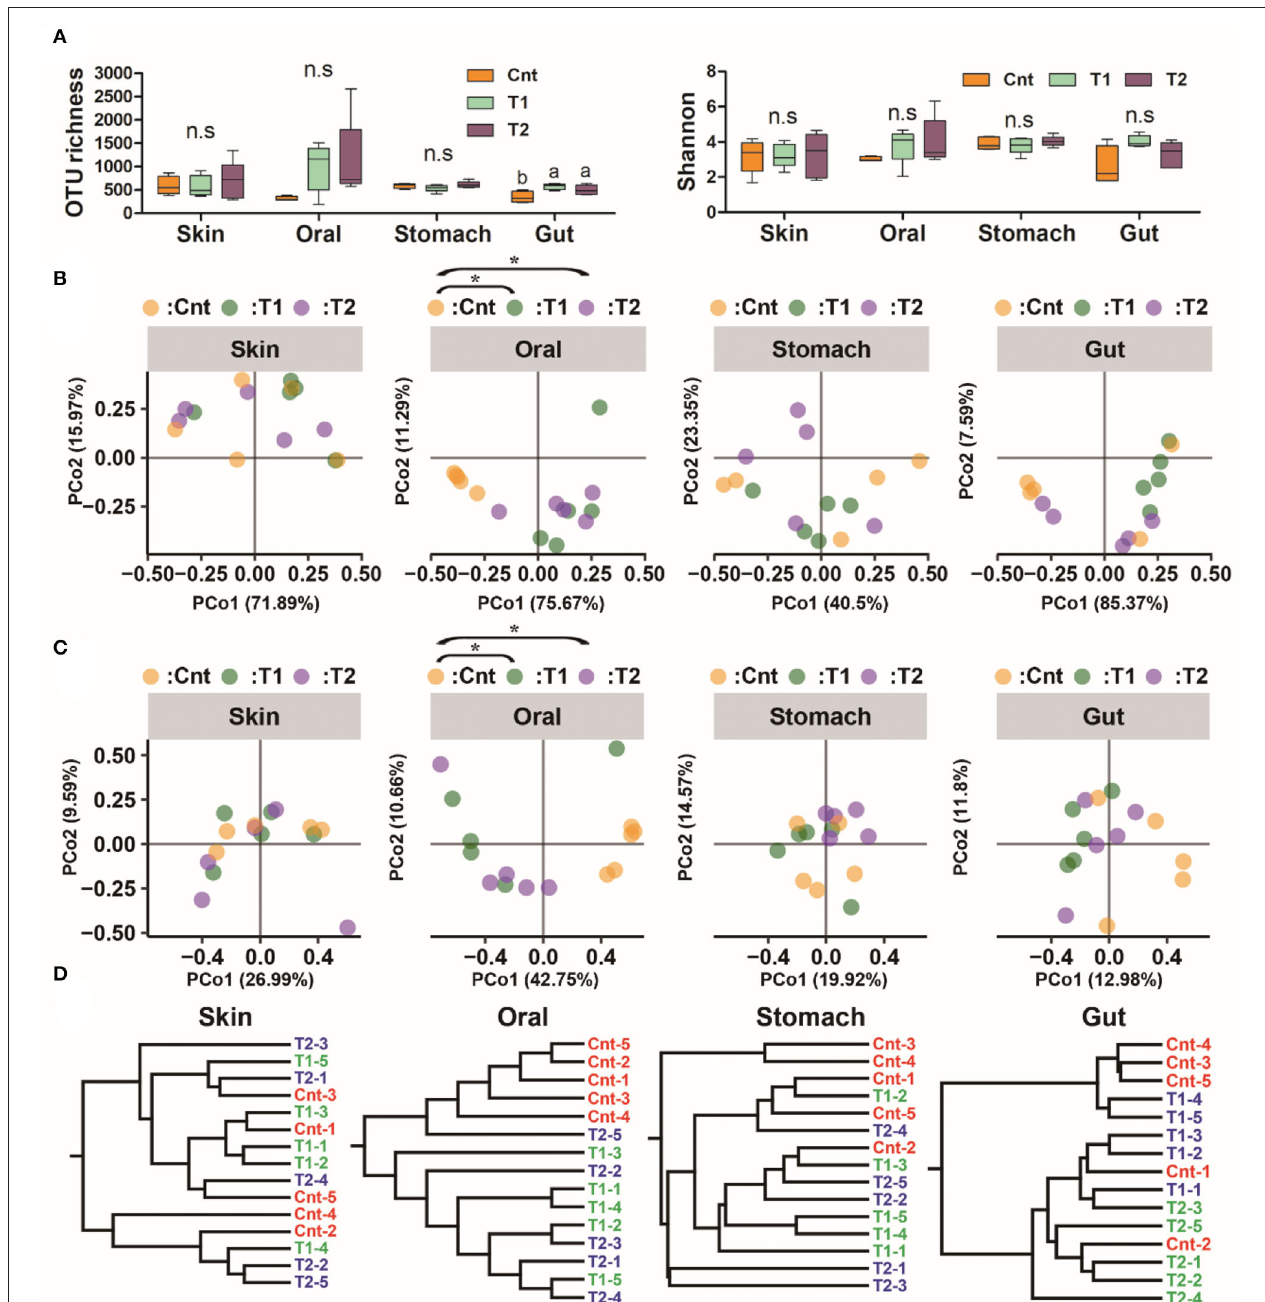
FIGURE 2 | Influence of pre-exposure on the symbiotic microbiota diversity of giant salamander. (A) Variation of microbiome alpha diversity (left: operational taxonomic units (OTU) number; right: Shannon index). Data are presented as means ± SE ( n = 5). The influences of pre-exposure on alpha diversity were tested using a one-way ANOVA and the Benjamini–Hochberg (BH) correction at the level of corrected p < 0.05. Different superscripts denote significant differences between groups (LSD post-hoc tests at p < 0.05) if there is a significant influence. (B,C) PCoA scatter plots present the dissimilarity of microbiomes at the OTU level [ (B) , based on weighted UniFrac distance; (C) , based on unweighted UniFrac distance]. *Corrected p < 0.05, PERMANOVA followed by BH correction. (D) Hierarchical clustering based on weighted UniFrac distance.